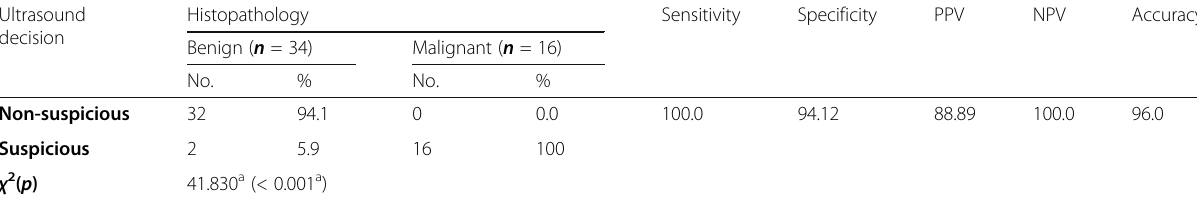
Table 4 Sensitivity and specificity for ultrasound decision in relation to the histopathological results Ultrasound